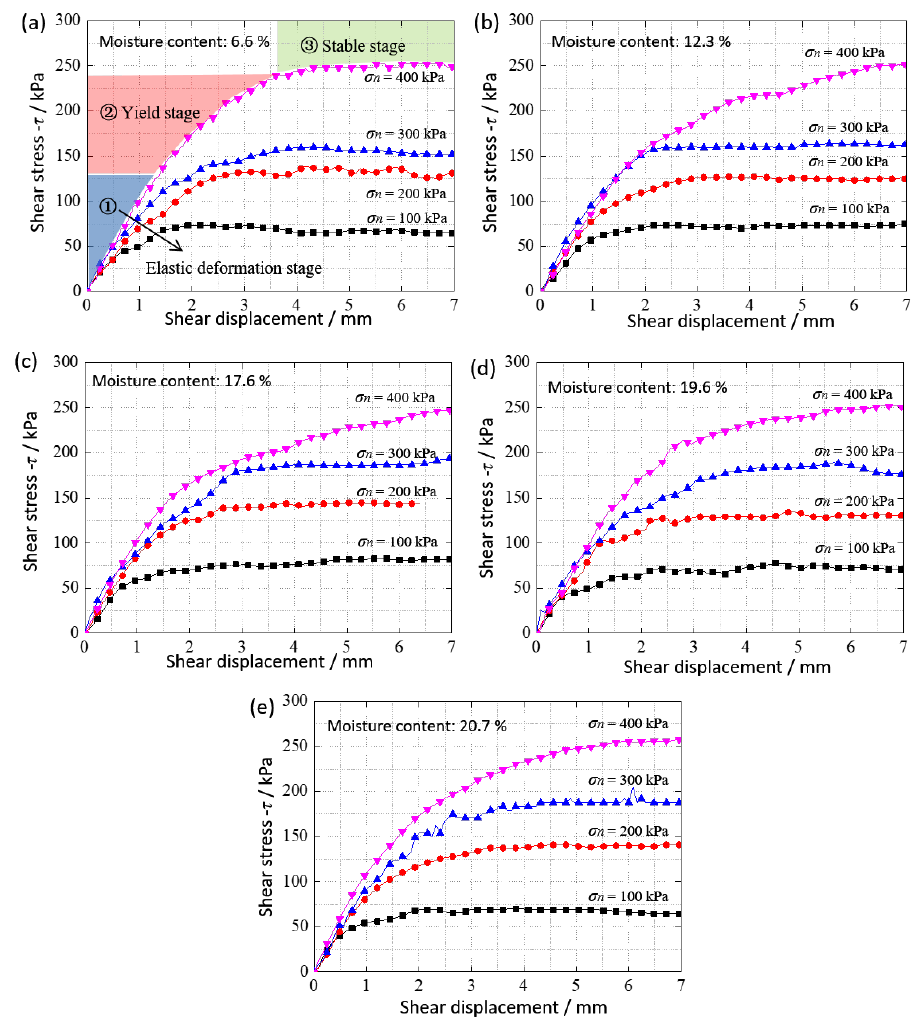
Figure 3. Typical stress-displacement curves under various normal stresses (i.e., 100 kPa, 200 kPa, 300 kPa, and 400 kPa,); ( a ) Moisture content is 6.6%; ( b ) Moisture content is 12.3%; ( c ) Moisture content is 17.6%; ( d ) Moisture content is 19.6%; ( e ) Moisture content is 20.7%.